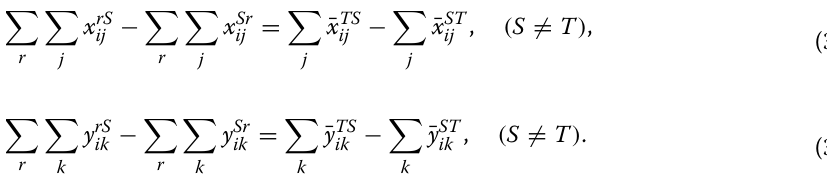
subject to the equation set A (Eqs. 11, 12, 15, 16, 19–21, 23–26, 30–33, 36–38) and sub- ject to all possible combinations in the equation set B (13, 14, 17, 18, 27, 27a, 28, 28a, 34, 34a, 35, 35a) using a grid-search